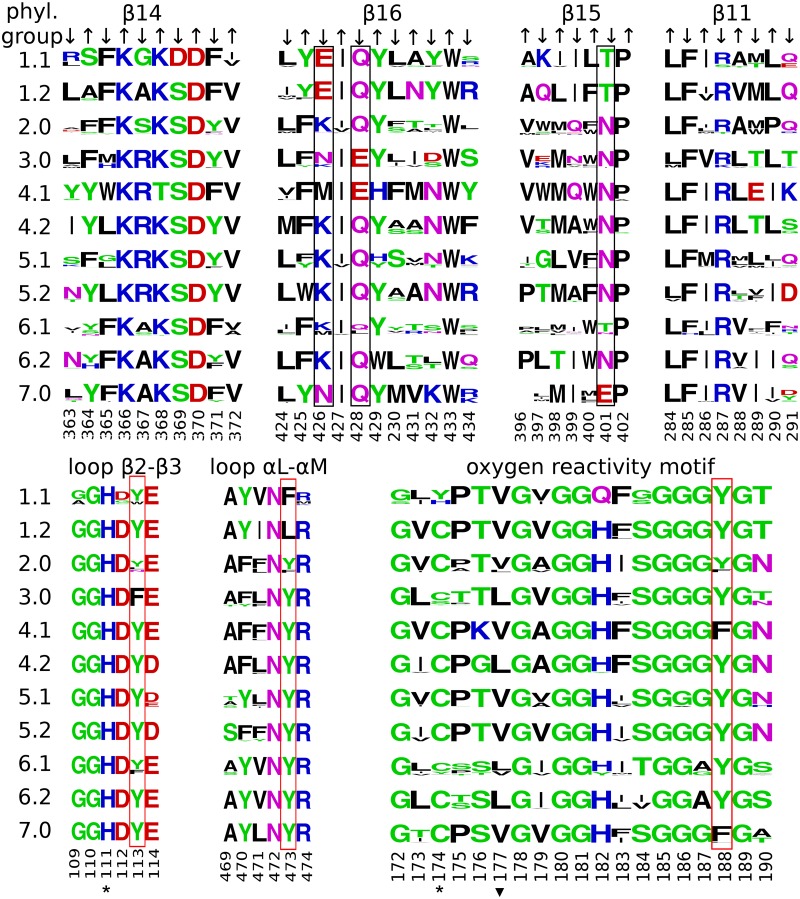
Sequence logos representing the secondary elements directly interacting with the isoalloxazine ring.The numbering is according to the sequence of AtBBE-like 28. *: site of covalent cofactor attachment, ▼: Gatekeeper residue controlling access to the oxygen pocket; valine is found in oxidases, leucine in dehydrogenases. Black boxes: Variable polar residues putatively involved in catalysis. Red boxes: Variable aromatic residues putatively involved in catalysis. β14, 16, 15 and 11 cover the si-side of the isoalloxazine ring. Arrows indicate the orientation of the residues in the β-strands. An upward arrow indicates the residue points towards the α-helices covering the 7-stranded antiparallel β-sheet (compare Fig 2B). These residues are found to be structurally relevant and are predominantly conserved in the overall family (compare β14 positions 366, 368, 370 and β16 position 433). A downward arrow indicates the residue points towards the active site. Residues contributing to the decoration of the active site are conserved within the phylogenetic groups but are variable within the overall family (compare β16 positions 426, 428 and β15 position 401).